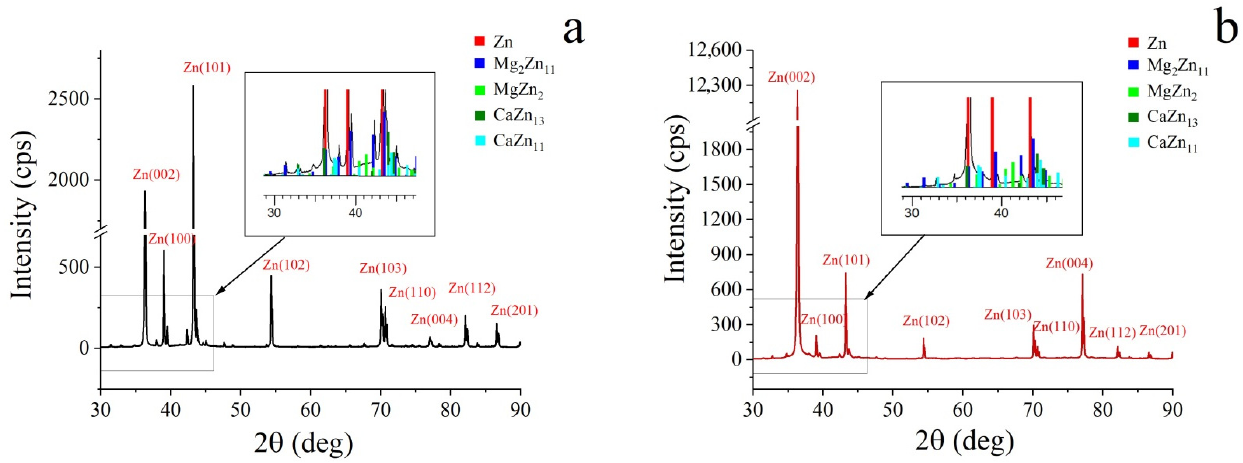
Table 2. Results of XRD analysis (Ritveld method) of the Zn-1%Mg-0.1%Ca alloy in the initial state and after HPT processing.